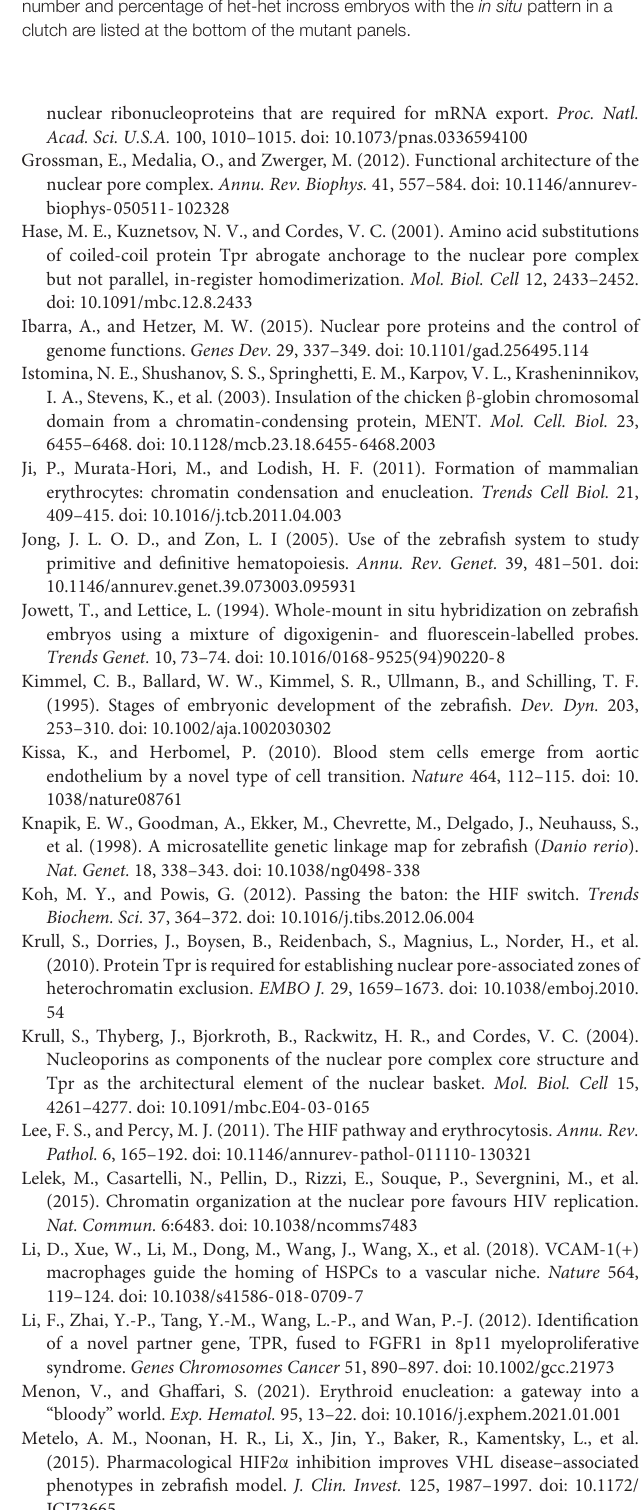
relative expression of TPR in different groups. (C) Representative FACS images of the ratio of CD235a-positive cells with or without hemin treatment. (D) Quantitative analysis of panel (C) . (E) The relative expression of α / β / γ / δ -globins with or without hemin treatment. Error bars represent SEM. ns, not significant; * p ≤ 0.05; ∗∗ p ≤ 0.01; ∗∗∗ p ≤ 0.001.